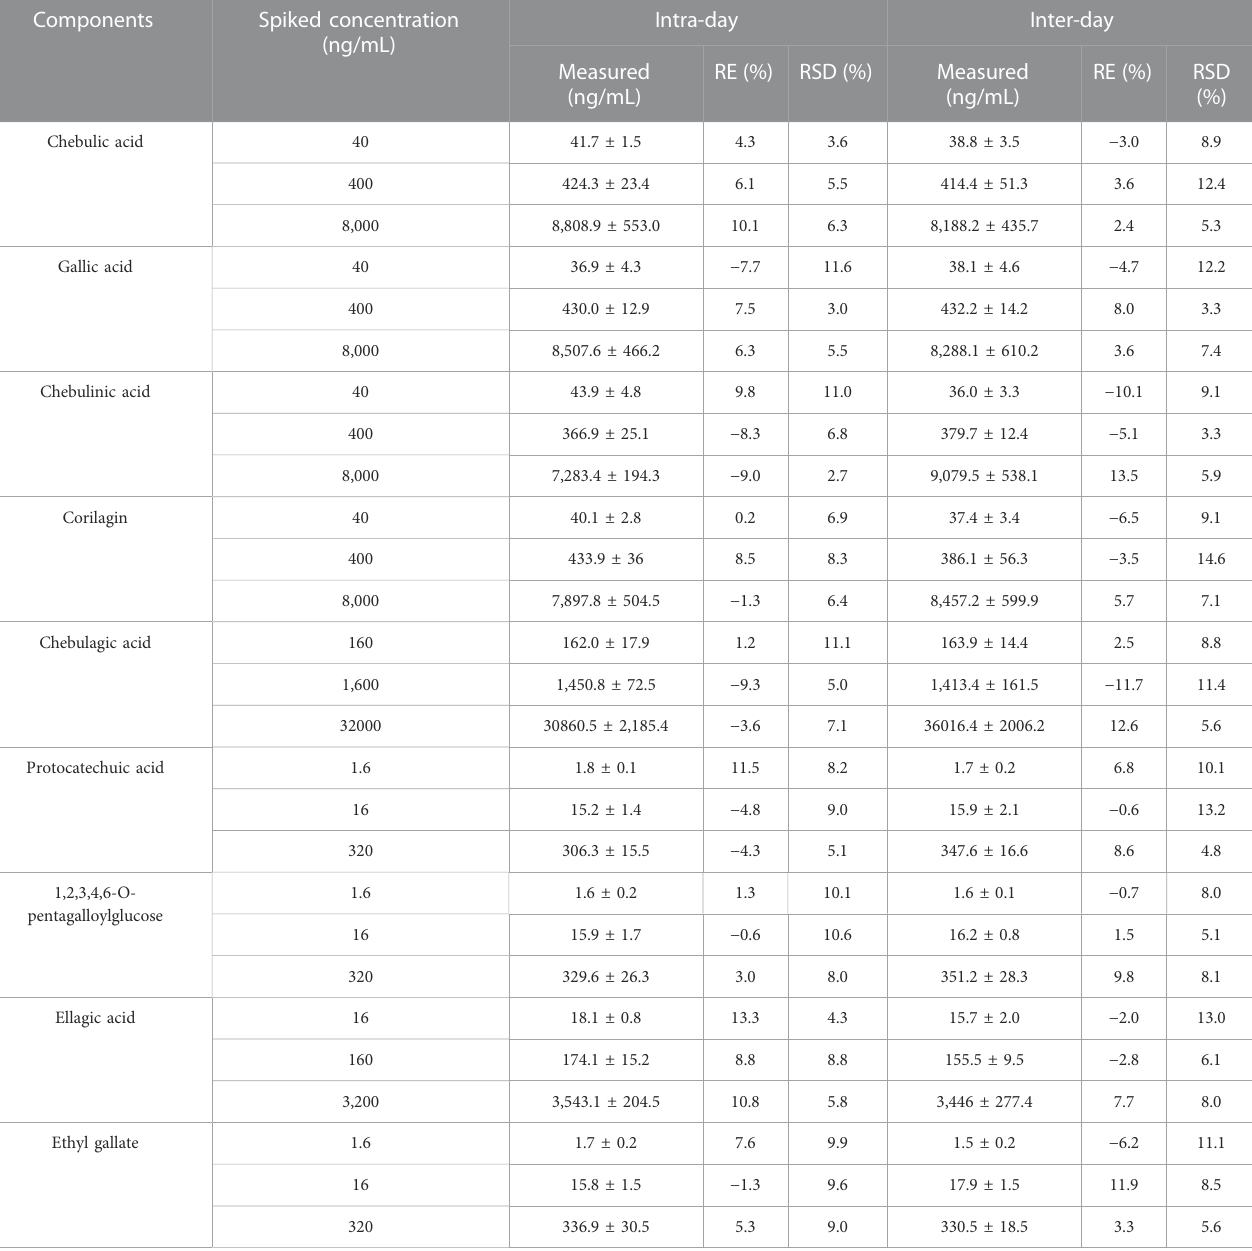
TABLE 4 Precision and accuracy of nine analytes in rat plasma ( n = 6).